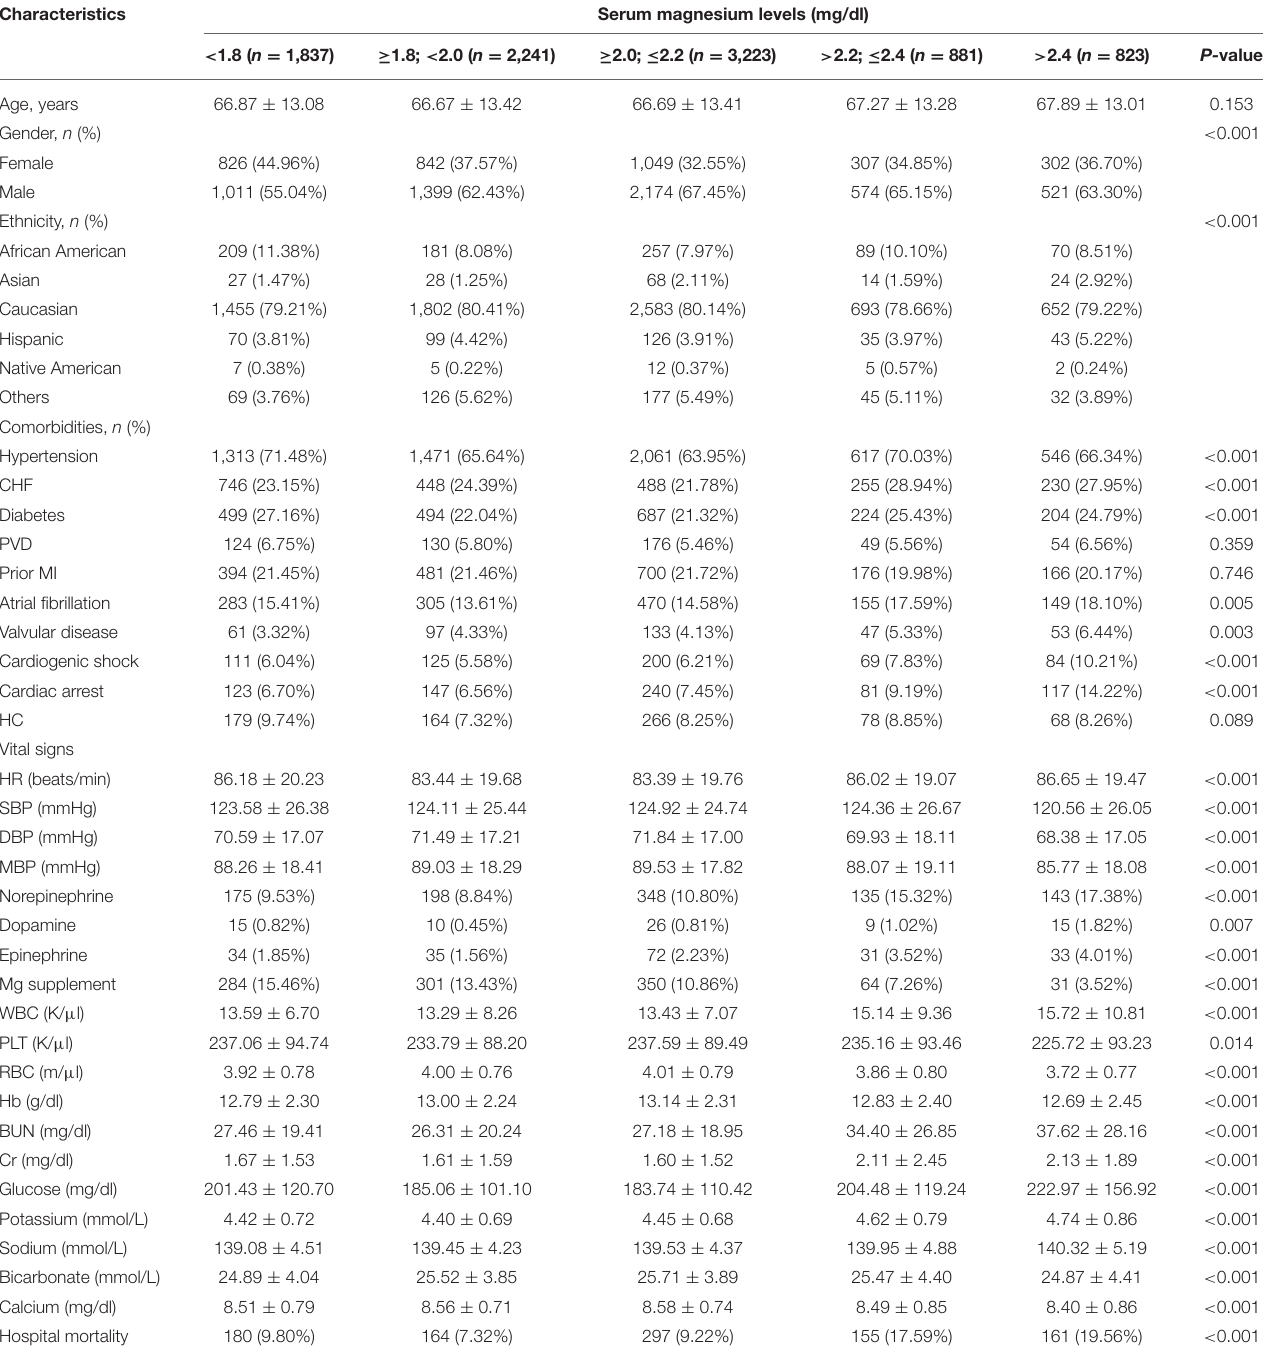
TABLE 1 | Characteristics of the included patients according to serum magnesium levels.